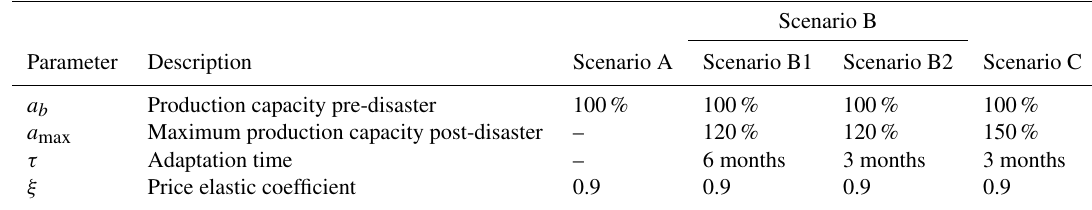
Table 2. ARIO model parameters and parameter settings of different post-disaster rescue scenarios for Beijing